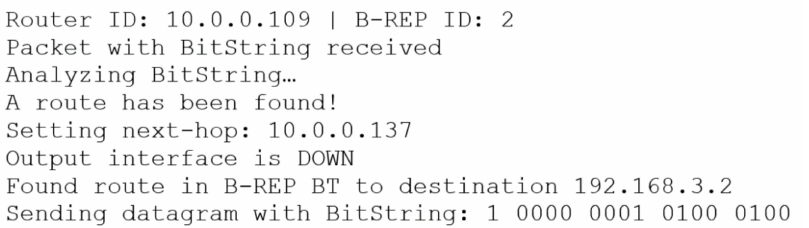
Figure 16. Output from R5—rerouting process.